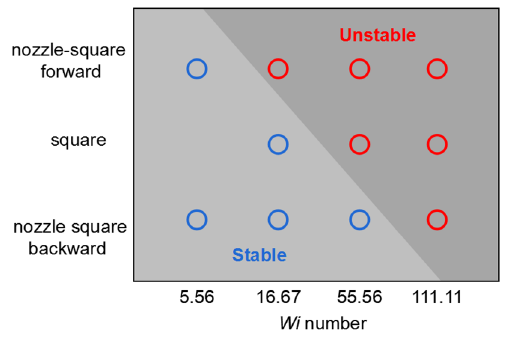
Figure 11. Critical Weissenberg number phase diagram for the two flow directions in the nozzle– square microchannel and the flow in the square-only microchannel. Figure 10. The PAM flow pattern in the symmetric square-only microchannel at three different in- stants ( a – c ) when Wi = 16.67, ( d – f ) when Wi = 55.56, and ( g – i ) when Wi = 111.11.